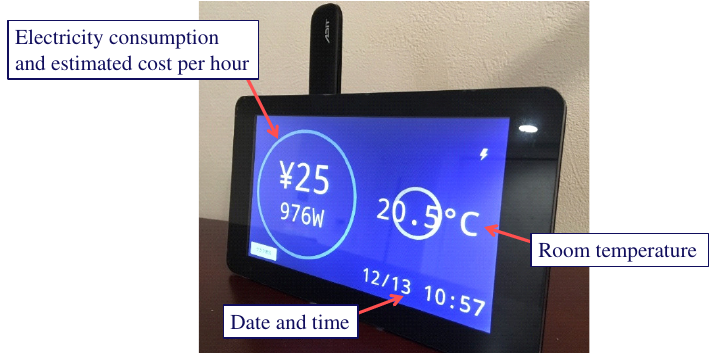
Figure 3. The developed sensor kit for in-home